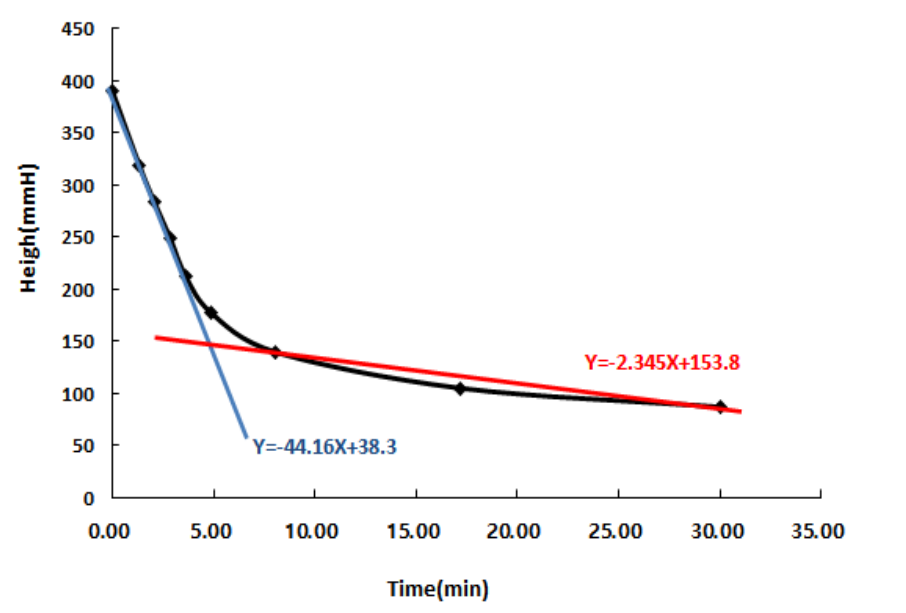
Figure 5. Visual test on sludge sedimentation trend.